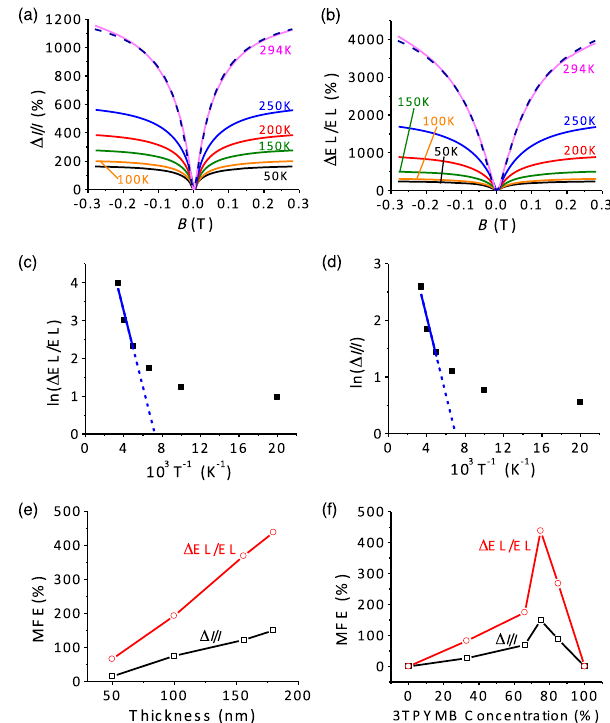
FIG. 7. (a),(b) Temperature dependence of magnetic-field effects in optimally conditioned device. Dashed lines are non- Lorentzian (as defined in text) fits. (c),(d) Arrhenius plot of the saturation magnetic-field effect extracted from the data in (a) and (b), respectively. Solid lines are fits to an activated Boltzmann law indicating the range of data points used in the fit, whereas the dashed lines are extrapolations to lower temperatures. (e) Dependence of the saturation magnetoconductance ( Δ I=I ) and magnetoluminescence ( Δ EL = EL) versus the thickness of the coevaporated layer, whereas (f) plots the same quantities versus the composition of the coevaporated